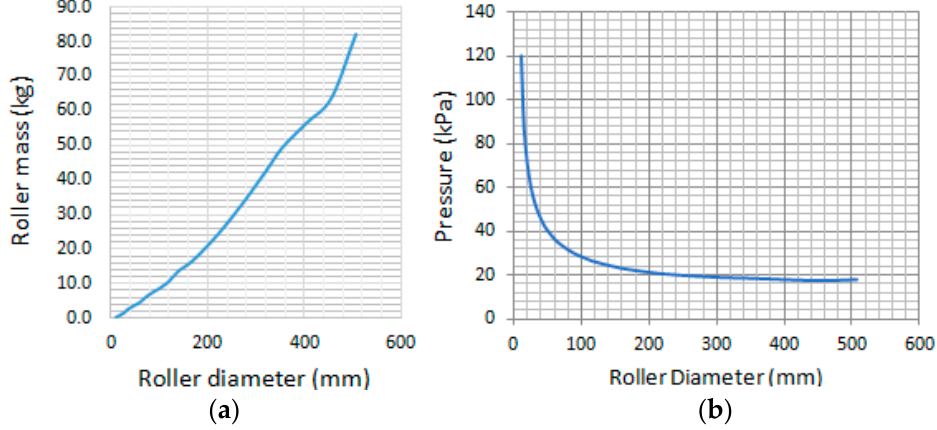
Figure 8. Plots of roller mass and pressure vs. roller diameter. ( a ) Roller mass m vs. roller diameter d ; ( b ) pressure p vs. roller diameter d .